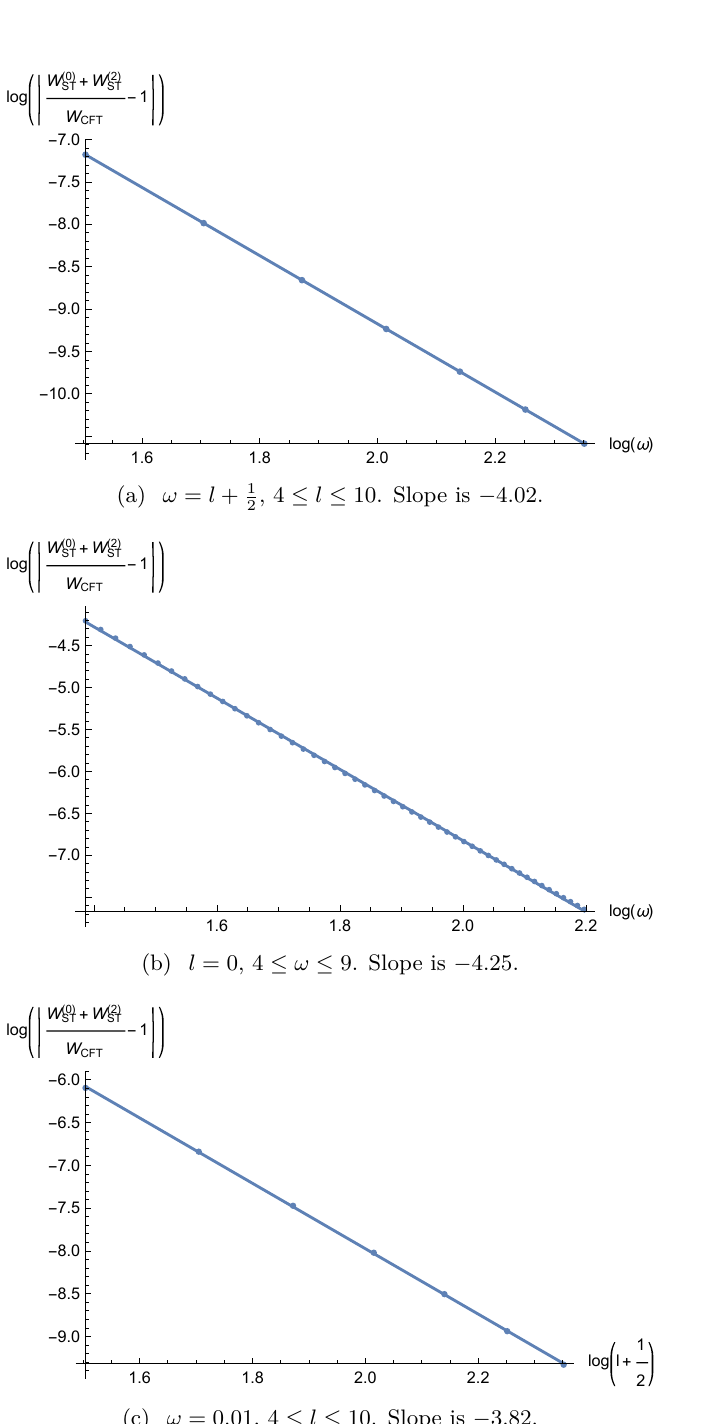
Figure 12 . Numerical log-log plots of the relative discrepancy between the CFT correlator and the (spin-0)+(spin-2) Sleight-Taronna contributions, at large boundary frequencies ω and/or l . As expected, the discrepancy decays with frequency as ∼ Ω − 4